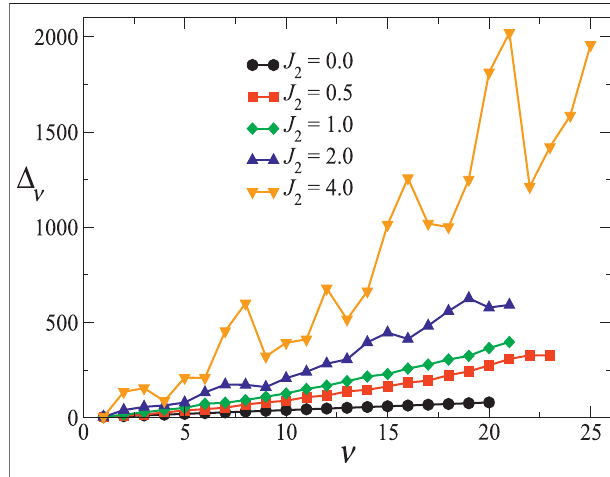
FIGURE 8 | Spectral density for the case B (cid:2) 2 and several values of J 2 . The plots were obtained for L (cid:2) 12 [17].